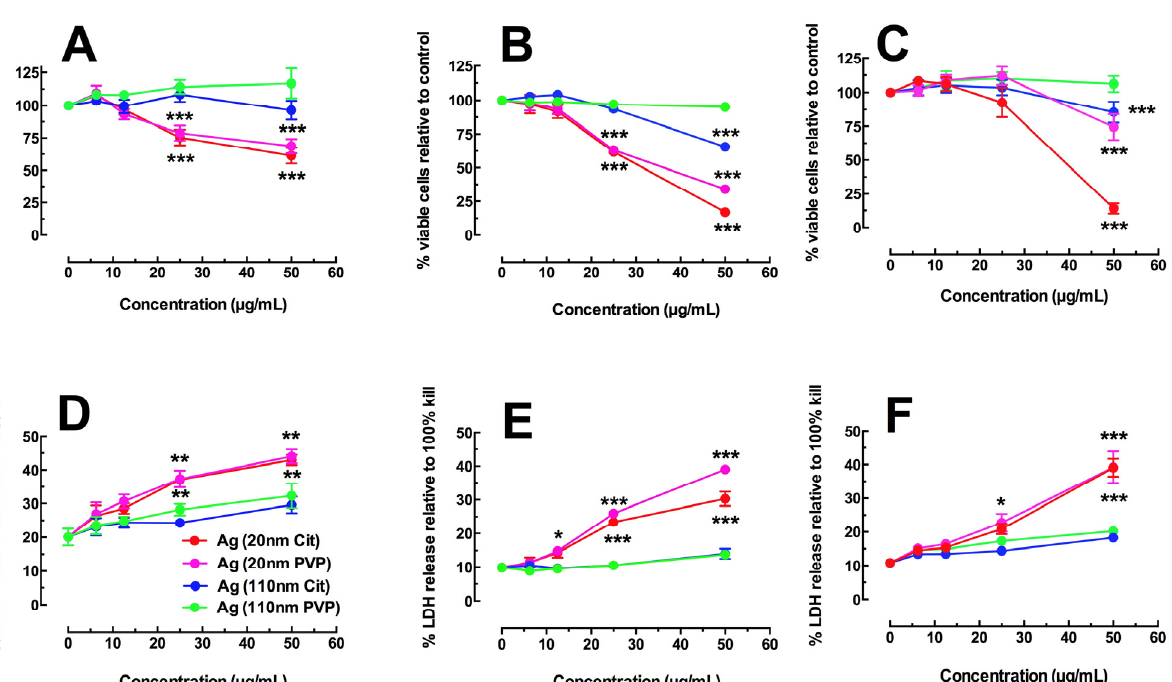
Figure 1. Toxicity of Ag nanospheres in three macrophage cell models using the MTS assay and LDH release assay at 24 h post particle exposure. ( A ) Percent viable cells compared to no particle (0 µg/mL) condition in the transformed THP-1 model; ( B ) Percent viable cells compared to no particle (0 µg/mL) condition in the C57BL/6 AM model; ( C ) Percent viable cells compared to no particle (0 µg/mL) condition in the MARCO null AM model; ( D ) Percent LDH release compared to 100% cell lysis in the transformed THP-1 model; ( E ) Percent LDH release compared to 100% cell lysis in the C57BL/6 AM model; ( F ) Percent LDH release compared to 100% cell lysis in the MARCO null AM model. All data expressed as mean ± SEM. Asterisks indicate significance at *** p < 0.001, ** p < 0.01, or * p < 0.05 compared to 0 µg/mL control condition by post hoc mean